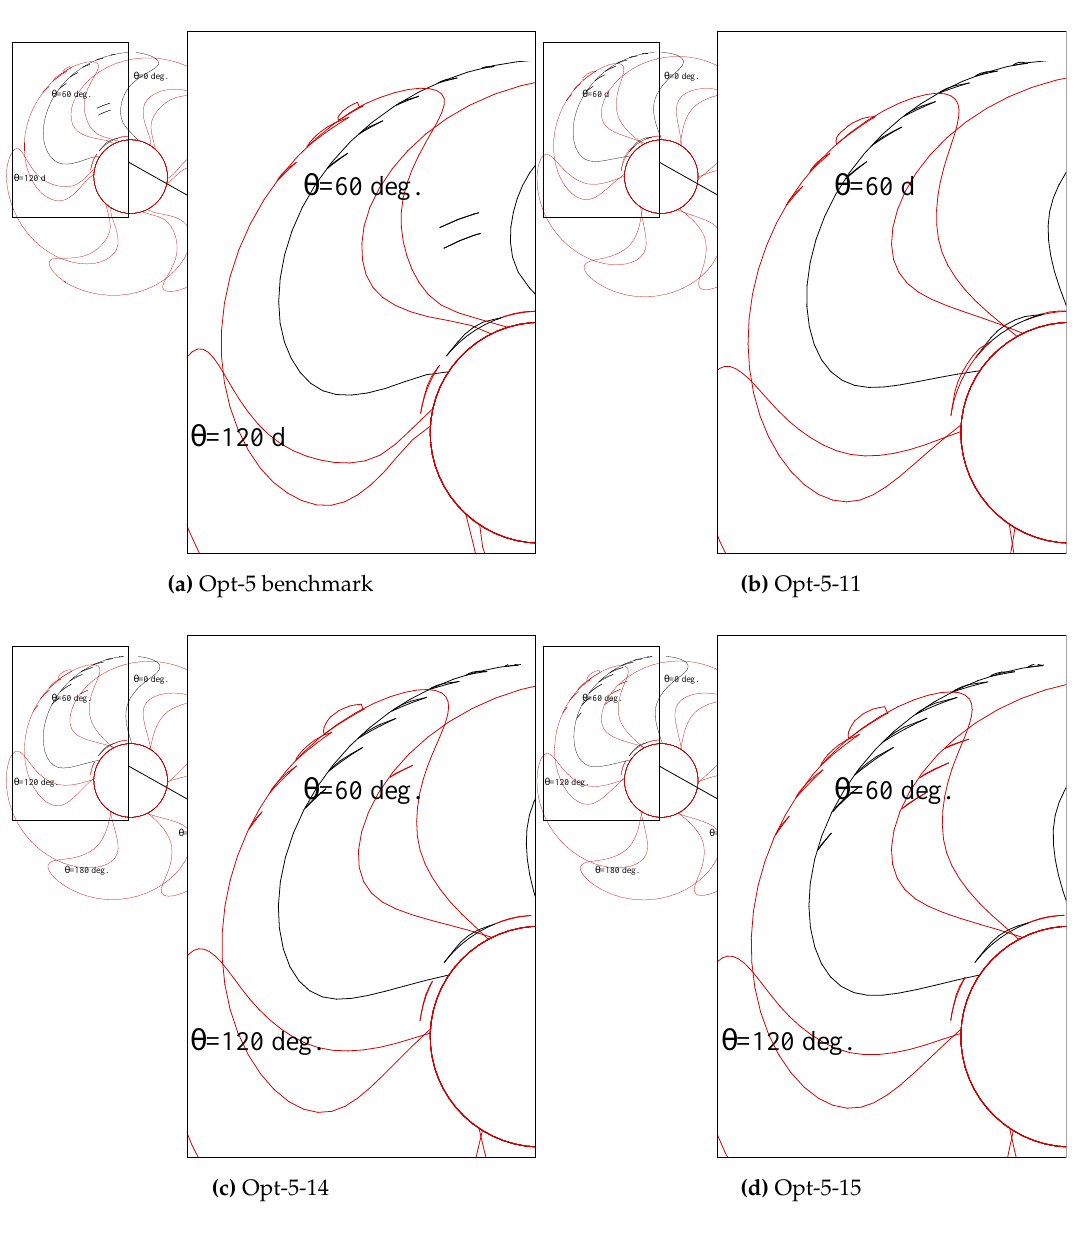
Figure 23. Cavitation performance of propeller case Opt-5 in comparison with the manual benchmark design. ( a ) Opt-5 benchmark; ( b ) Opt-5-11; ( c ) Opt-5-14; ( d )